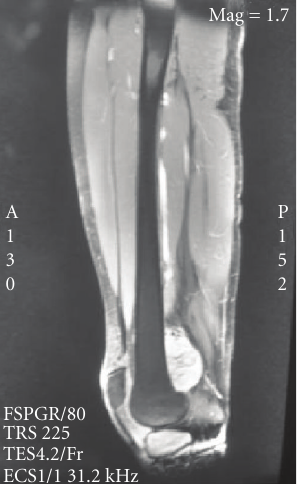
Figure 3: Preoperative MRI showed a relatively dense and well- demarcated ossified mass at a juxtacortical lesion of the distal femur without medullar involvement.